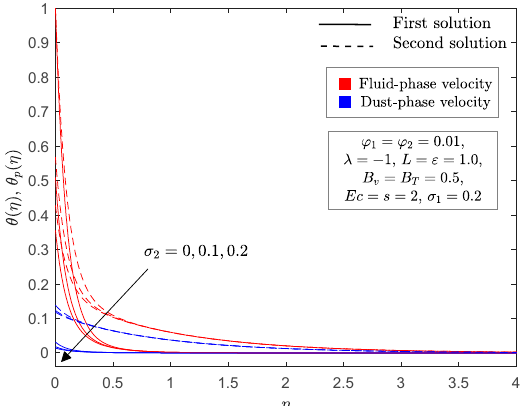
Figure 12. θ ( η ) , θ p ( η ) for selected values of σ 2 . ( ) ( ) θη θ η for selected values of , Figure 12. p